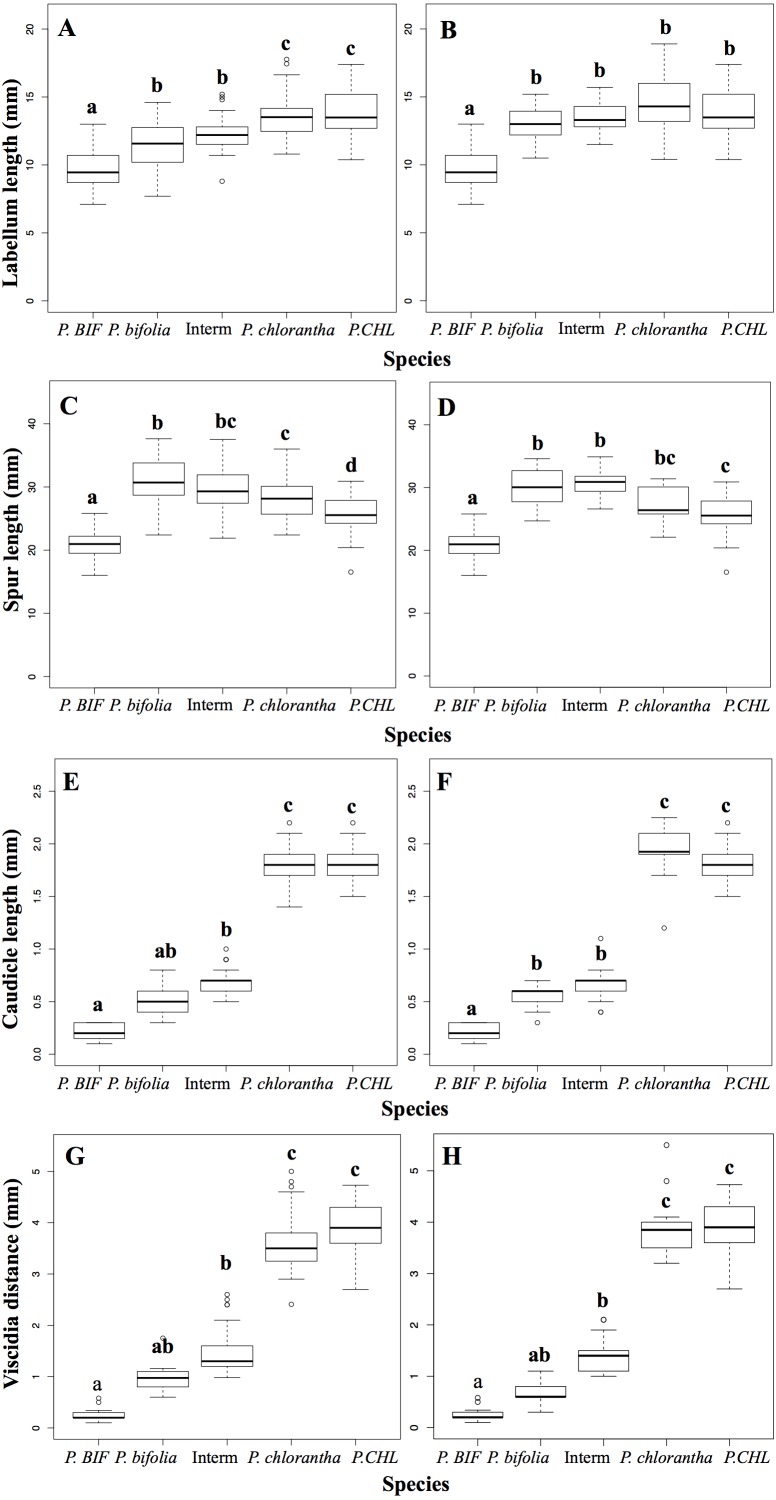
Box plots of floral morphological traits among different taxa and populations.(A, C, E, G): Box plots of allopatric populations and sympatric population of Botton. (B, D, F, H): Box plots of allopatric populations and sympatric population of Bois Niau. Different letters on top of boxplots indicate significant differences. Abbreviations: P. BIF, P. bifolia allopatric;  P. CHL, P. chlorantha allopatric.